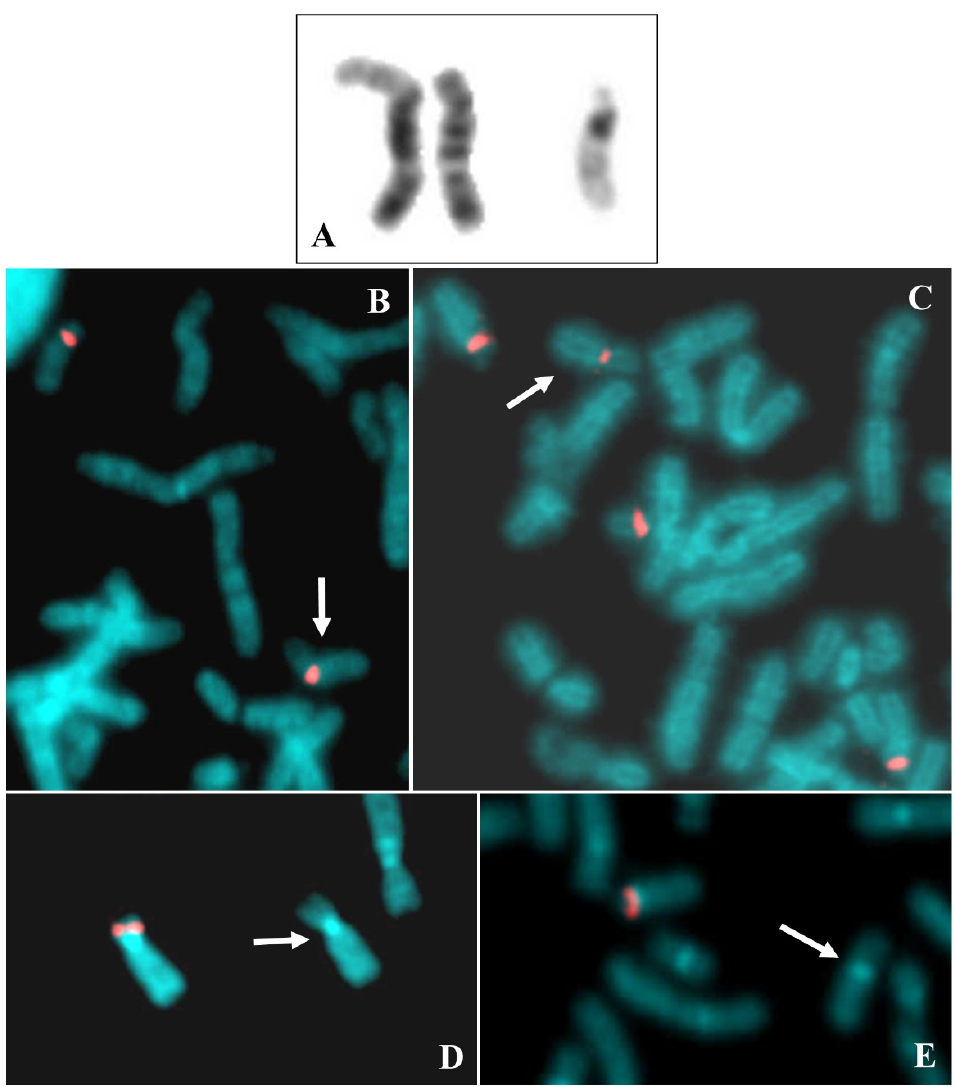
Figure 2. Case 2. ( A ) Chromosomes 18 and 22 from a GTG stained metaphase, left chromosome 18 translocated with 22q, right normal chromosomes 18 and the normal 22. ( B ) Partial metaphase after FISH with D18Z1, the arrow indicates t(18;22)(q10;q10). ( C ) FISH with probe D14Z1D22Z1, the arrow indicates t(18;22)(q10;q10). ( D ) FISH with BAC RP11 19M2 (18p 11.21), the arrow indicates t(18;22)(q10;q10). ( E ) FISH with BAC RP11 48H7 (18p 11.21), the arrow indicates t(18;22)(q10;q10).